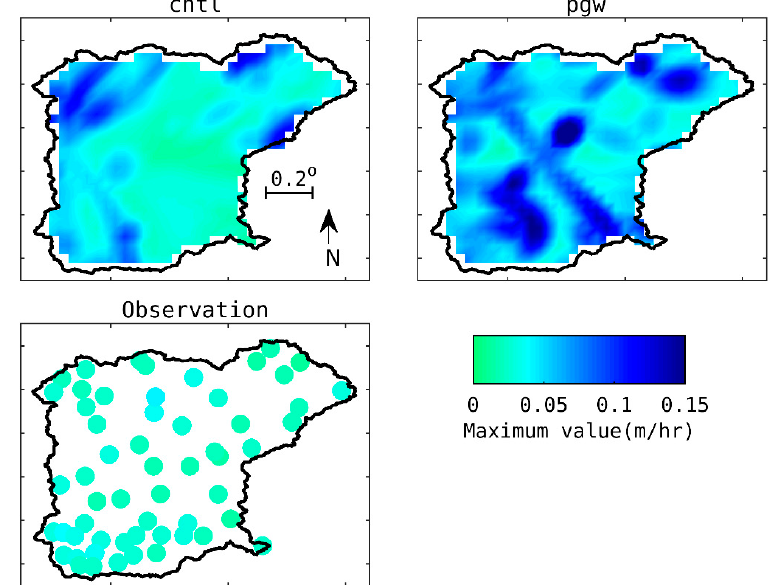
Figure 3. Spatial distributions of the maximum precipitation of CNTL, PGW, and observed data during the August 2016 disaster.